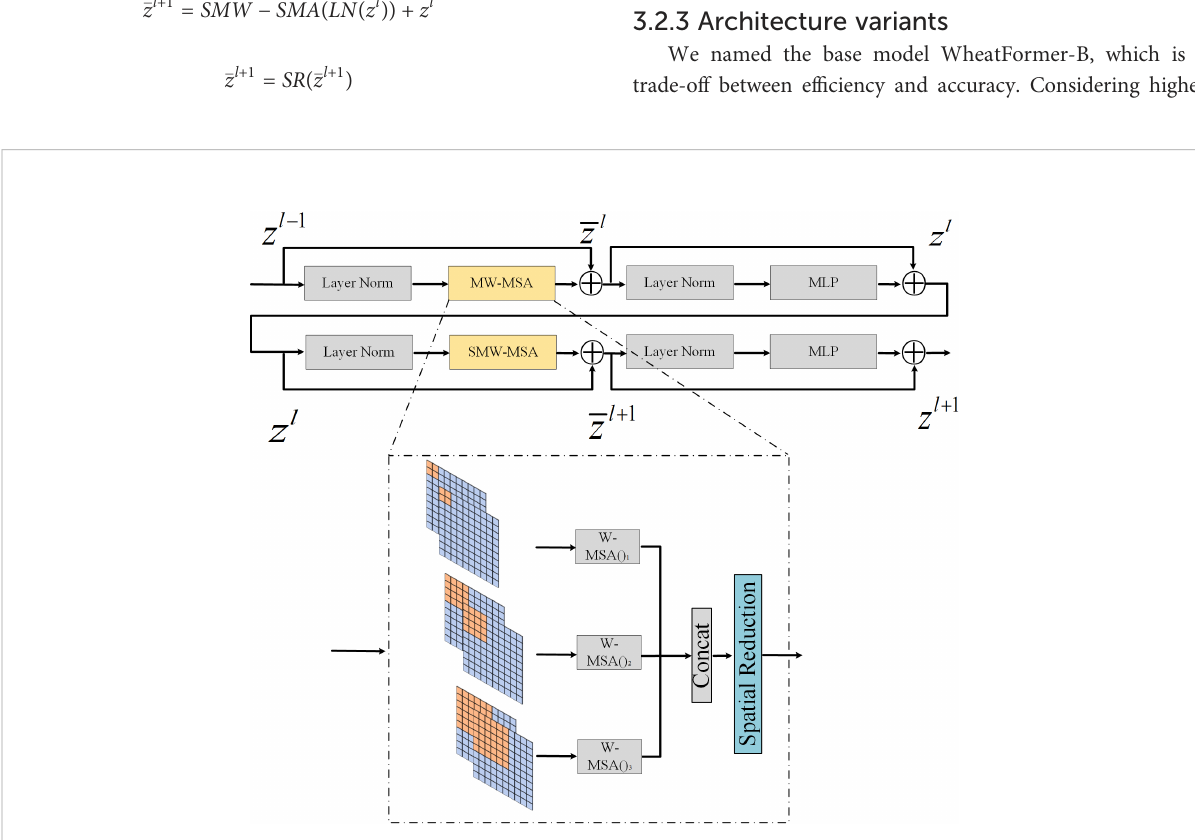
FIGURE 3 MW-Swin Transformer